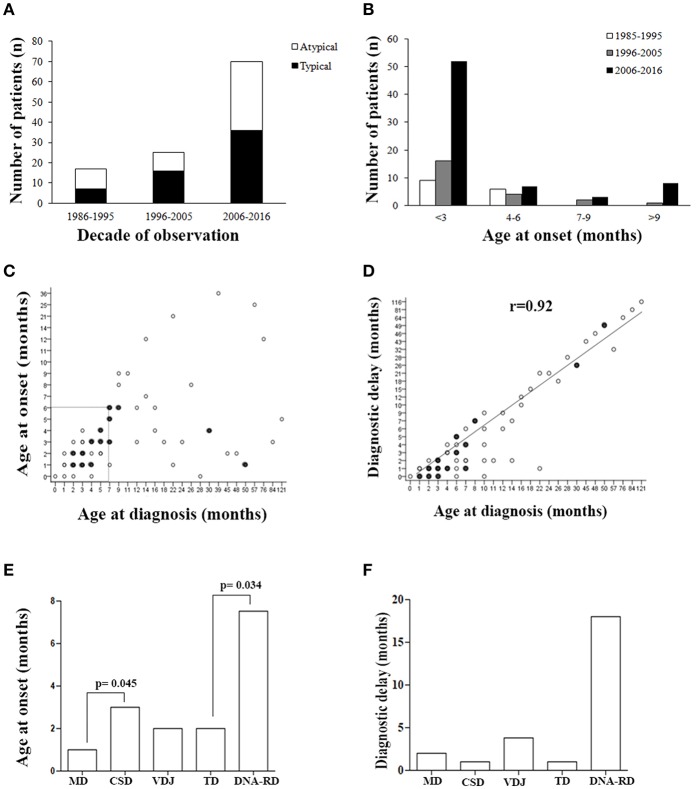
Patients' demographics. (A) Number of typical or atypical SCID patients diagnosed during the overall study period. (B) Histogram distribution of patients grouped by age at onset. (C) Correlation between age at onset and age at diagnosis, and (D) between age at diagnosis and diagnostic delay. Filled circles indicate groups of SCID patients (between 2 and 5) with same values. (E) Age at onset and (F) diagnostic delay (median) for the various pathogenic group of SCID. MD, Metabolic Disorders; CSD, Cytokine Signaling Disorders; VDJ, VDJ abnormalities; TD, Thymic Disorders; DNA-RD, DNA Repair Disorders.